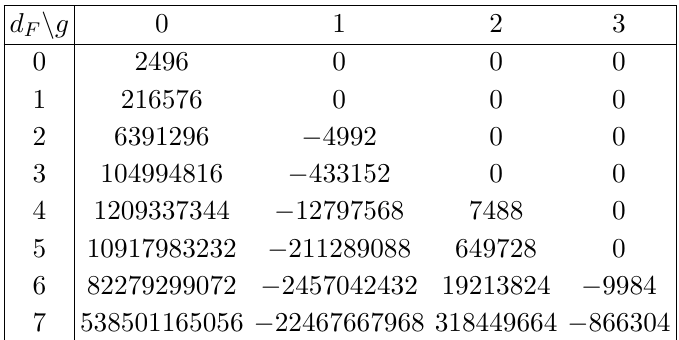
Table 5 . Gopakumar-Vafa invariants for ( F 4 ! P 2 )[ Z 2 ] (cid:0) 252